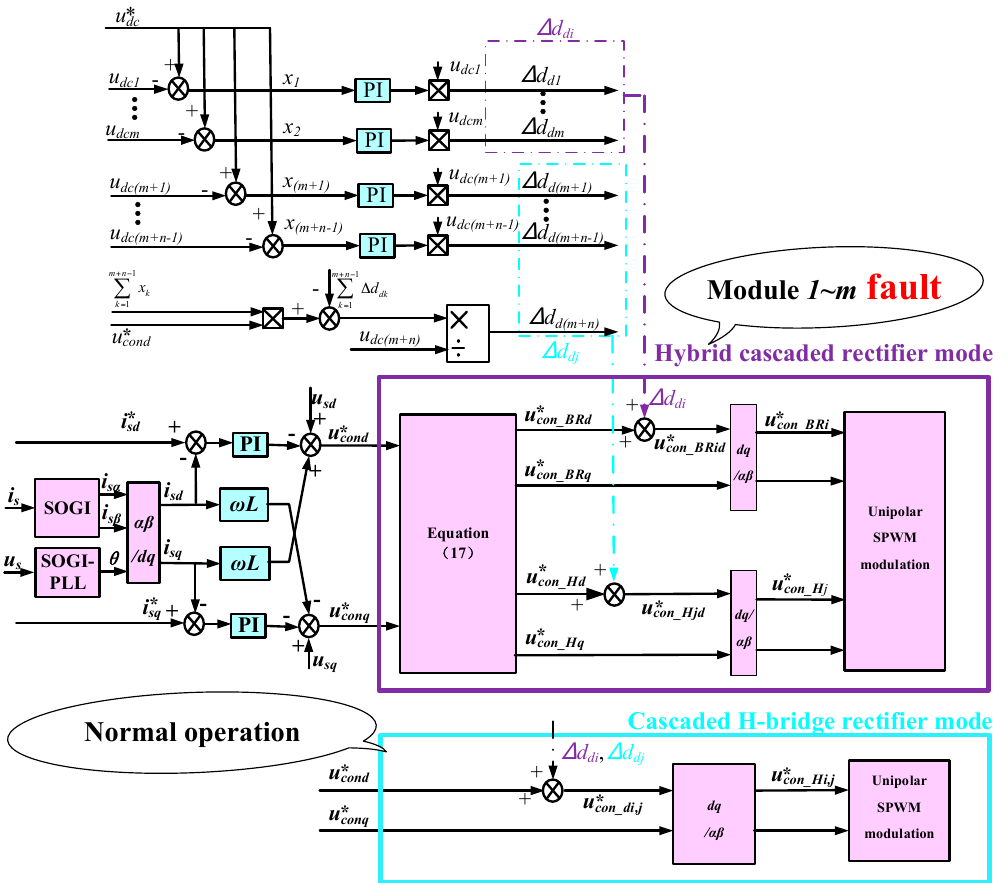
Figure 6. Control diagram of the multifunctional cascaded H-bridge rectifier under the faulty condition and normal operation.